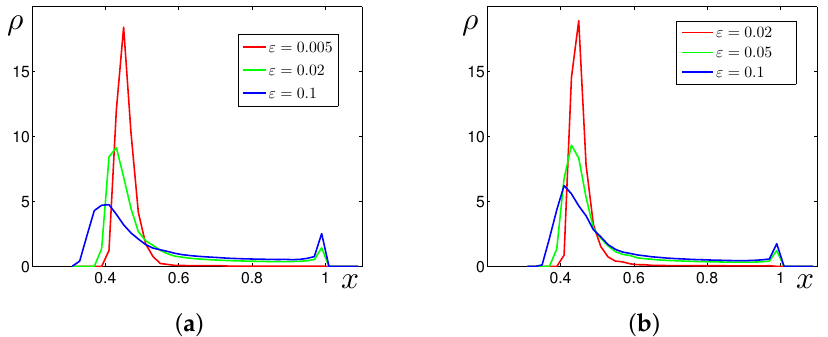
Figure 7. Stochastic P -bifurcations in the system with ( a ) for D = 0.248, ( b ) for D = 0.3.